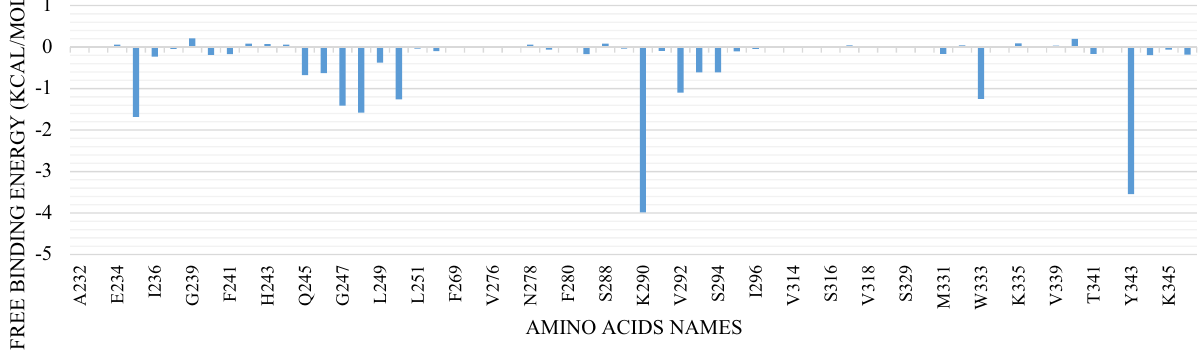
Figure 6. Molecular Mechanics Generalized Born Surface Area (MM-GBSA) decomposition of NSP15- ZINC000104379474 complex. It shows the contribution of amino acids within 1 nm of the ZINC000104379474 compound. System ∆E VDW ∆E ELE